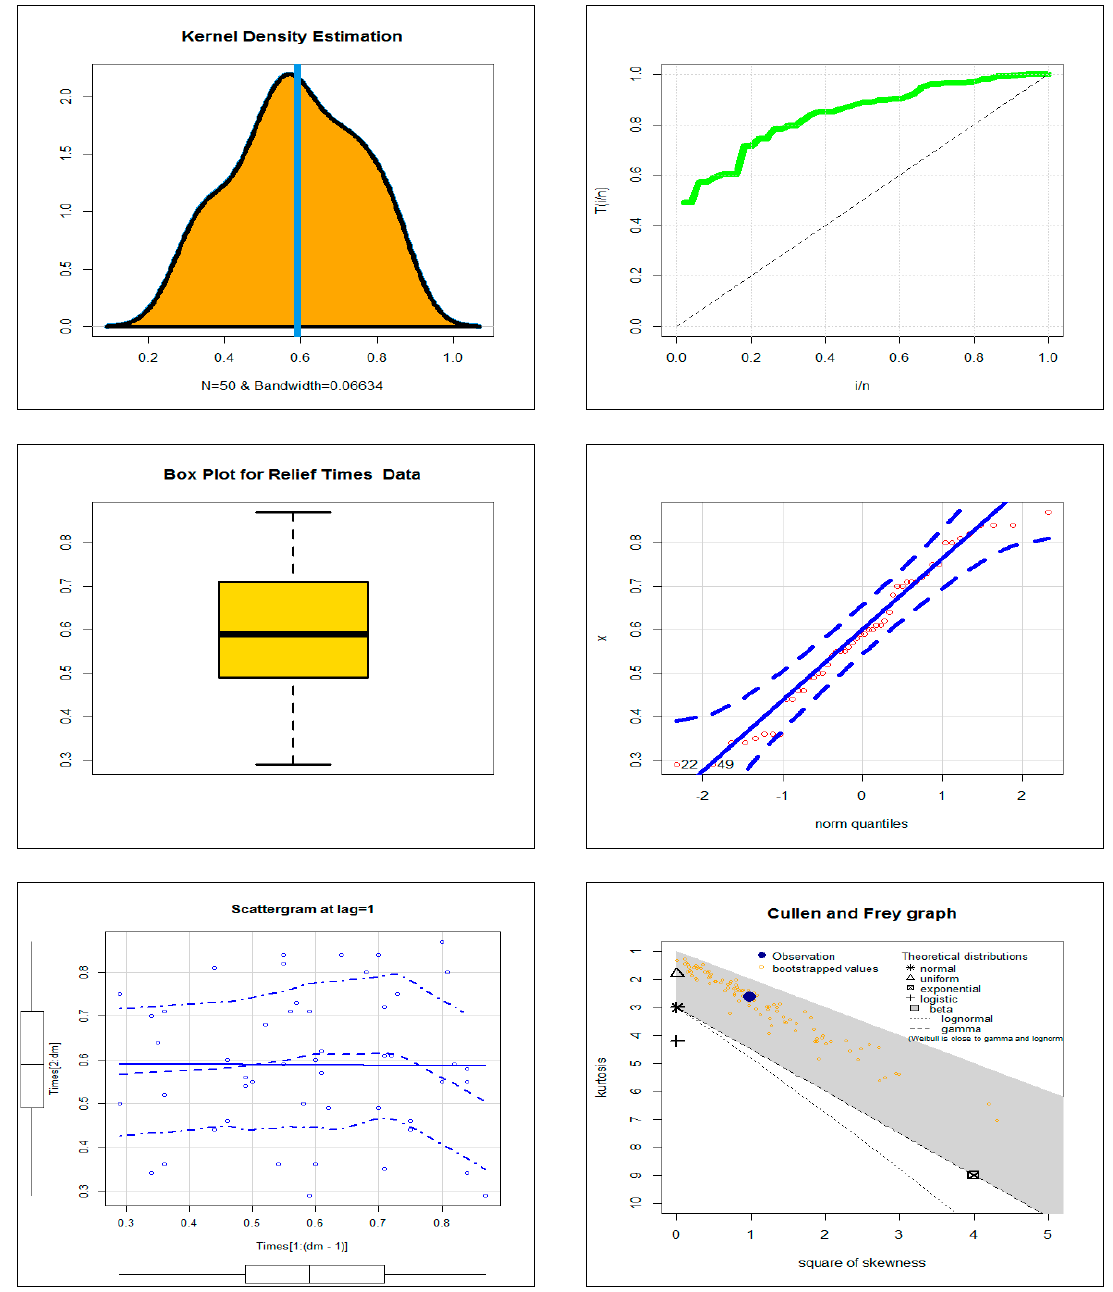
Figure 7. The NKDE panel (the first row, left panel), the TTT panel (the first row, right panel), the box panel (the second row, left panel), the Q-Q panel (the second row, right panel), scattergram panel (the third row, left panel), and the skewness-kurtosis panel (the third row, right panel) for the relief times.